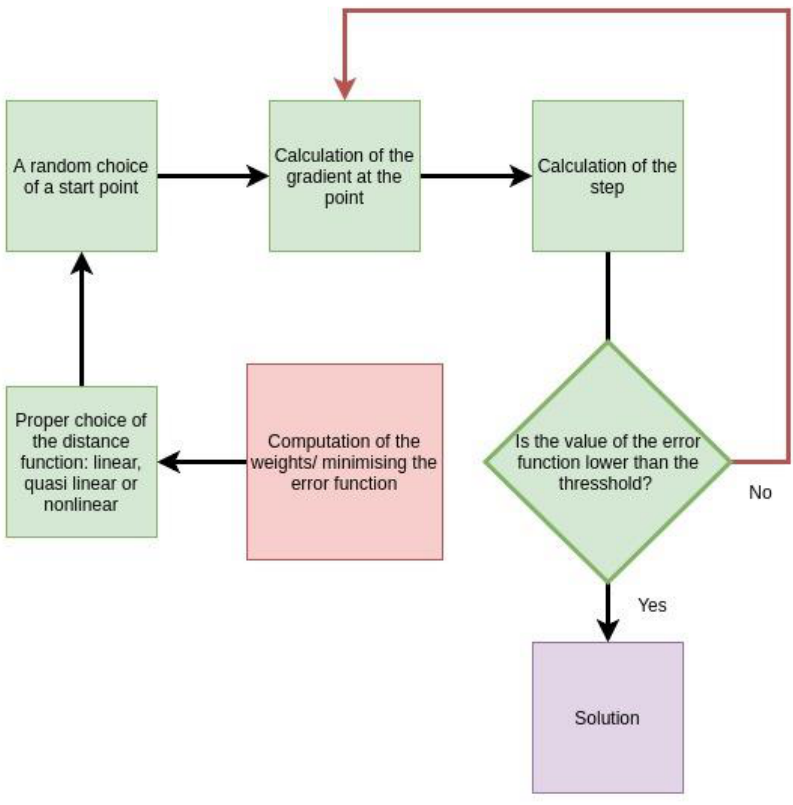
Figure 5. The main steps of the algorithm.